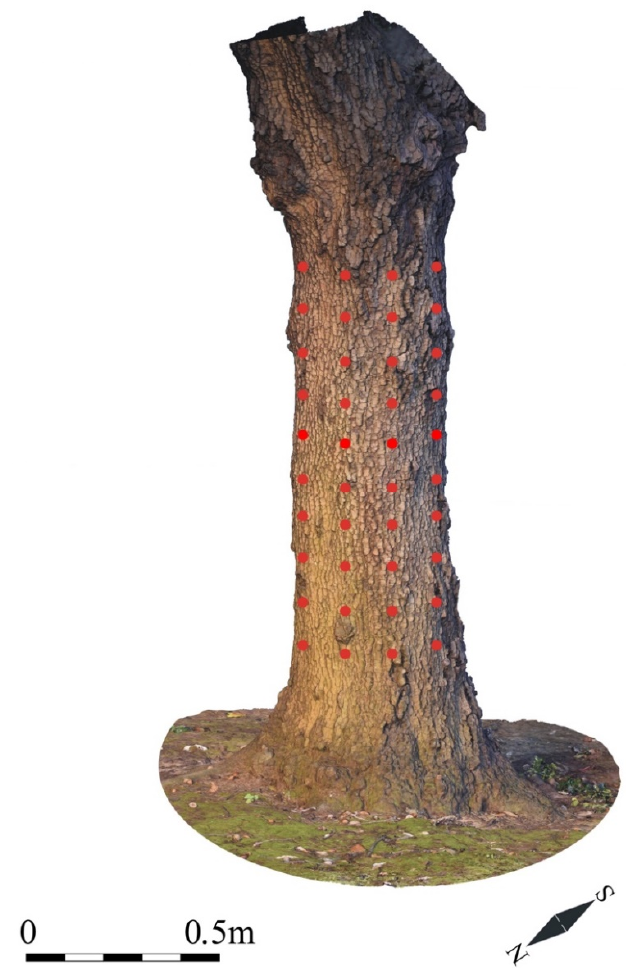
Figure 6. Ultrasonic measurement point locations in the 3D CRP model.